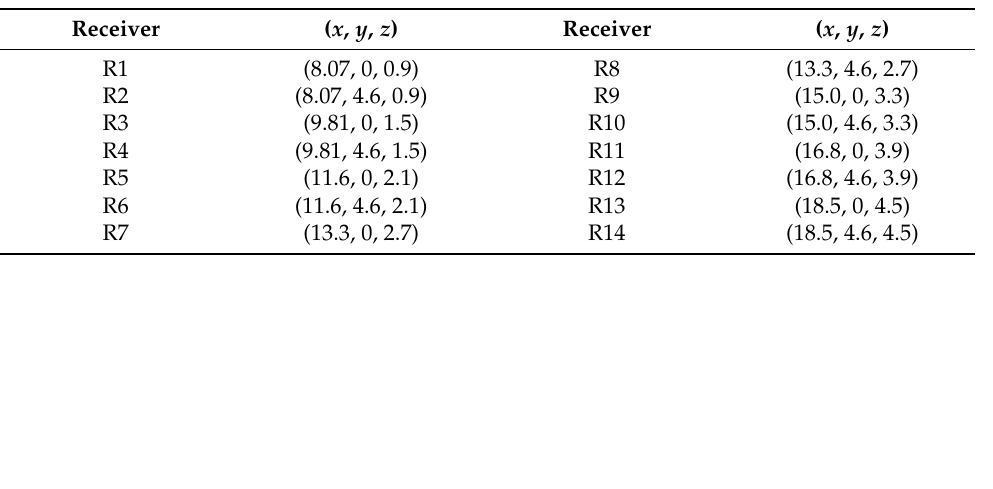
Table 5. Locations of receivers in the auditorium